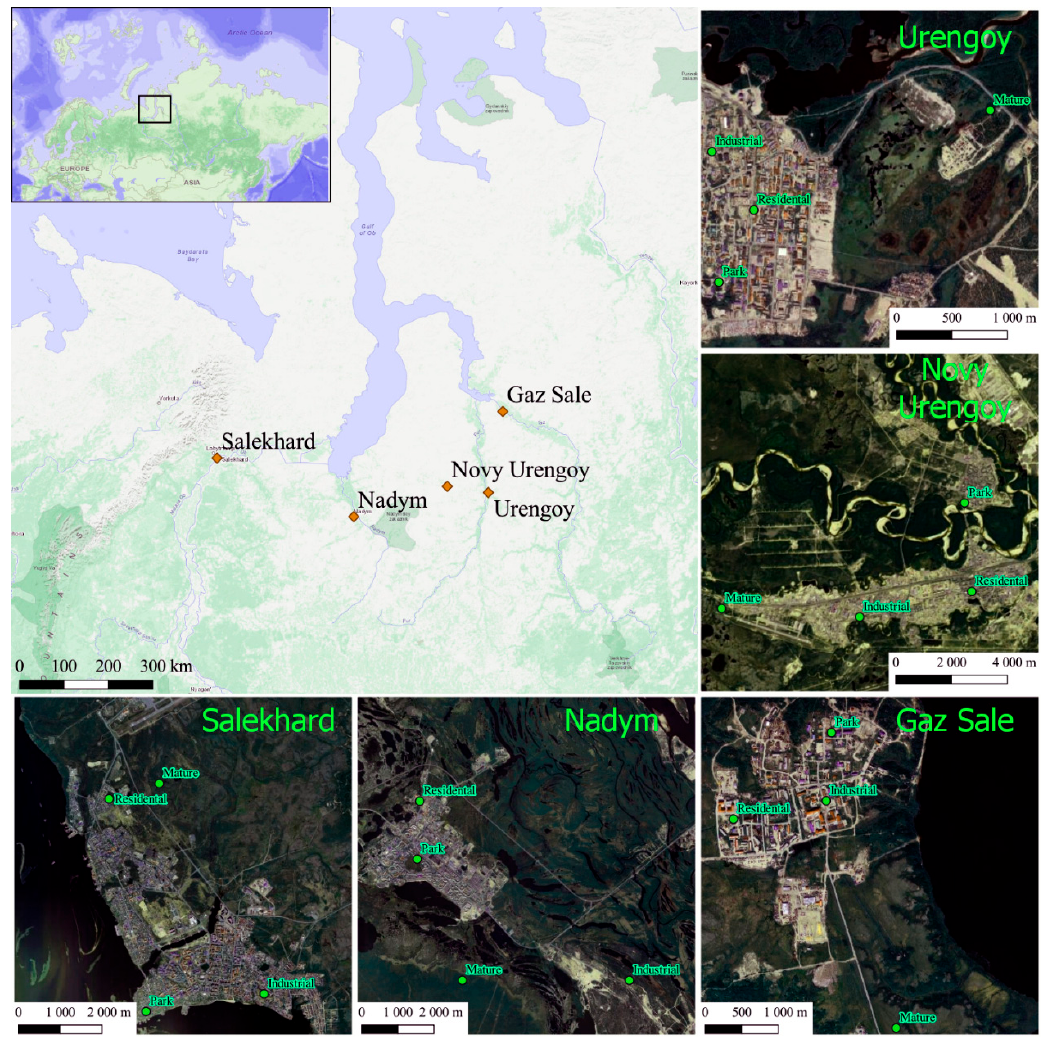
Figure 1. Location of studied cities and sampling locations in functional zones (black box—location of YANAO).